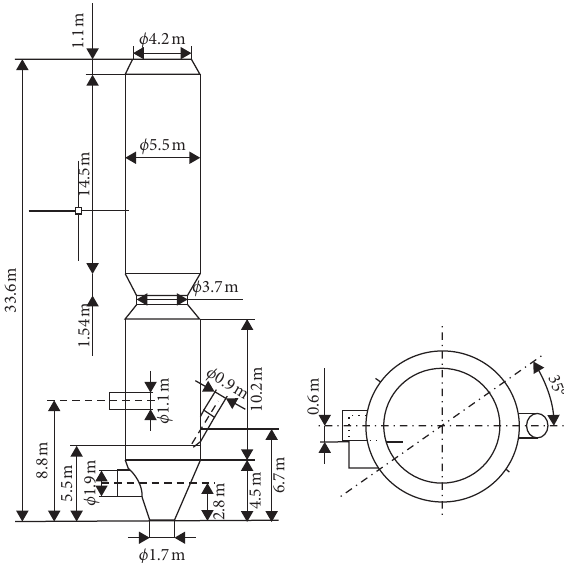
Figure 2: Dimensions of the decomposing furnace.